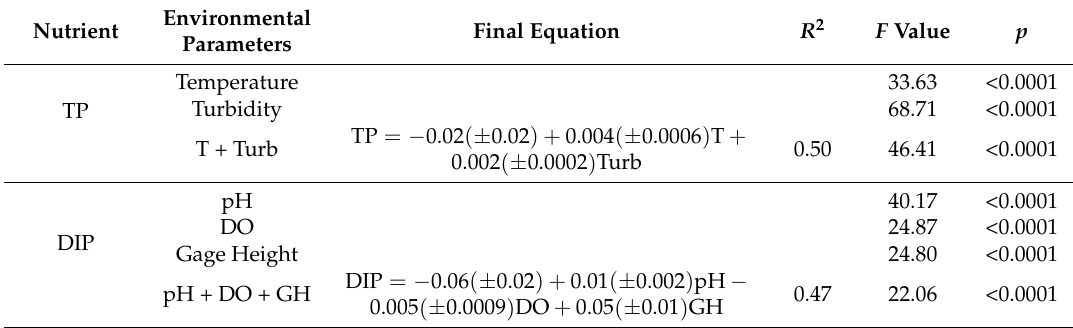
Table 6. Relationships between phosphorus concentrations and environment parameters from all six sampling sites in the Calcasieu River using backward stepwise linear regression. Slope and intercept estimates are presented with standard errors ( ± SE). Only statistically significant relationships are reported ( p < 0.05). Variables left in the model are significant at the 0.05 level. T = temperature; Turb = turbility; DO = dissolved oxygen concentration; GH = gage